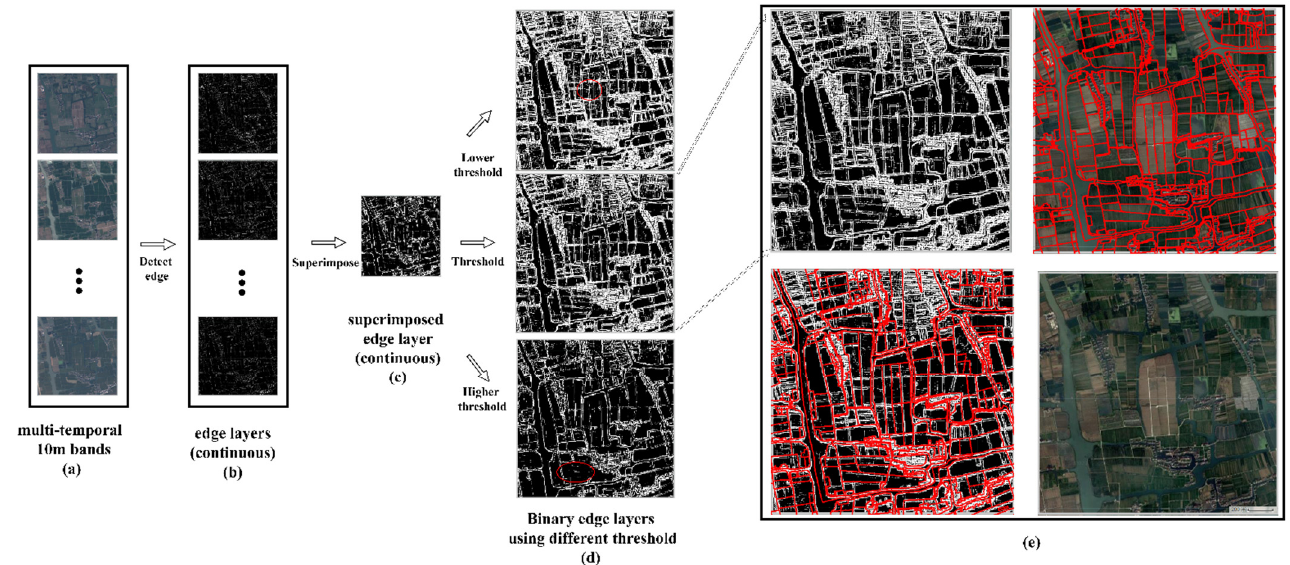
Figure 4. The workflow graph showcases the procedure of multi-temporal edge detection analysis. Multiple edge layers ( b ) are extracted from multiple corresponding Sentinel-2 10m bands ( a ), then superimposed to single edge layer ( c ). The continuous edge layer is thresholded to binary edge layers ( d ), where the black is non-edge region (agricultural fields) and the white is the edge region. The red ellipses in ( d ) show examples of over-segmentation where a single field is separated by false edges, and under-segmentation where multiple fields with different crops planted are not separated. ( e ) from left to right and top to bottom shows the zoom-in binary edge of that in the middle of ( d ), reference edge over VHR images, reference edge over detected edge, and VHR image, respectively. It should be noted that we use cadastral boundaries as reference edges, so some reference edges are redundant (e.g., division lines in river) and some are missing where multiple fields have the same ownership.